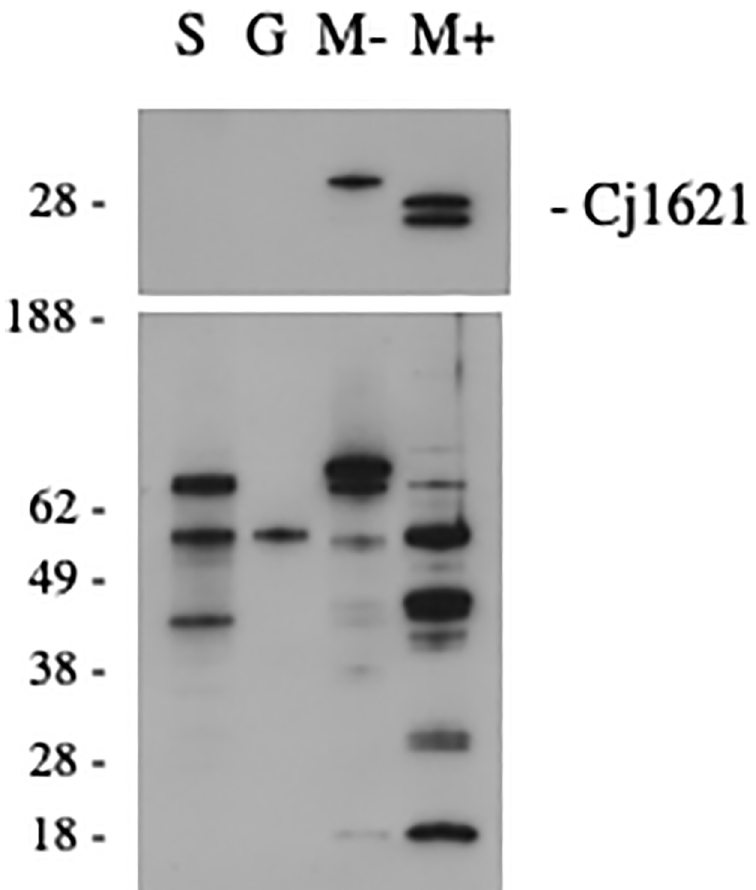
Fig 6. Membrane localization of endogenous Cj1621. Protein fractions were probed with rabbit antiserum raised against denatured recombinant Cj1621 (upper panel) or antiserum from C . jejuni -infected mouse (lower panel). S. secretory, G. acid glycine extract, M-, membrane depleted or intracellular, M+, membrane enriched.